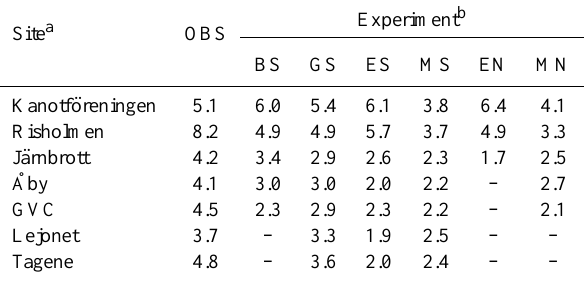
c Refer to Table 1 for abbreviations of the experiments. Table 4. Observed (OBS) and simulated sea breeze strengthwith different experiments at all observational sites on 8 May 2001. Sea breeze strength is defined as the first peak value of observed and simulated near-surface wind speed during SB hours (cf. Table 3).